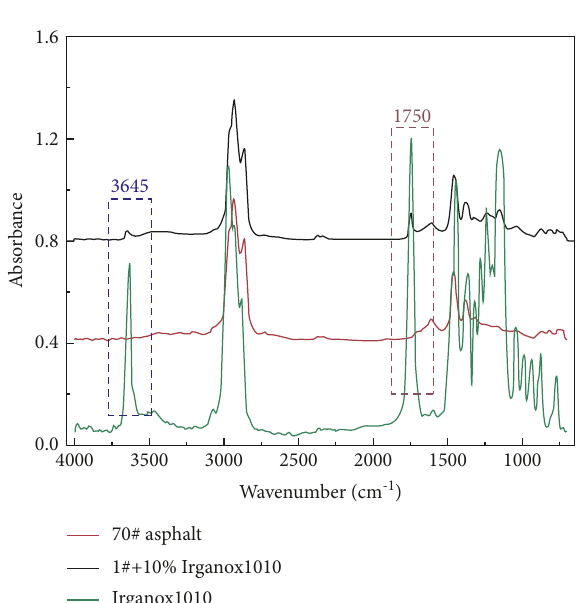
Figure 8: Spectra of Irganox 1010, base asphalt, and 1#+ 10% Irganox 1010.